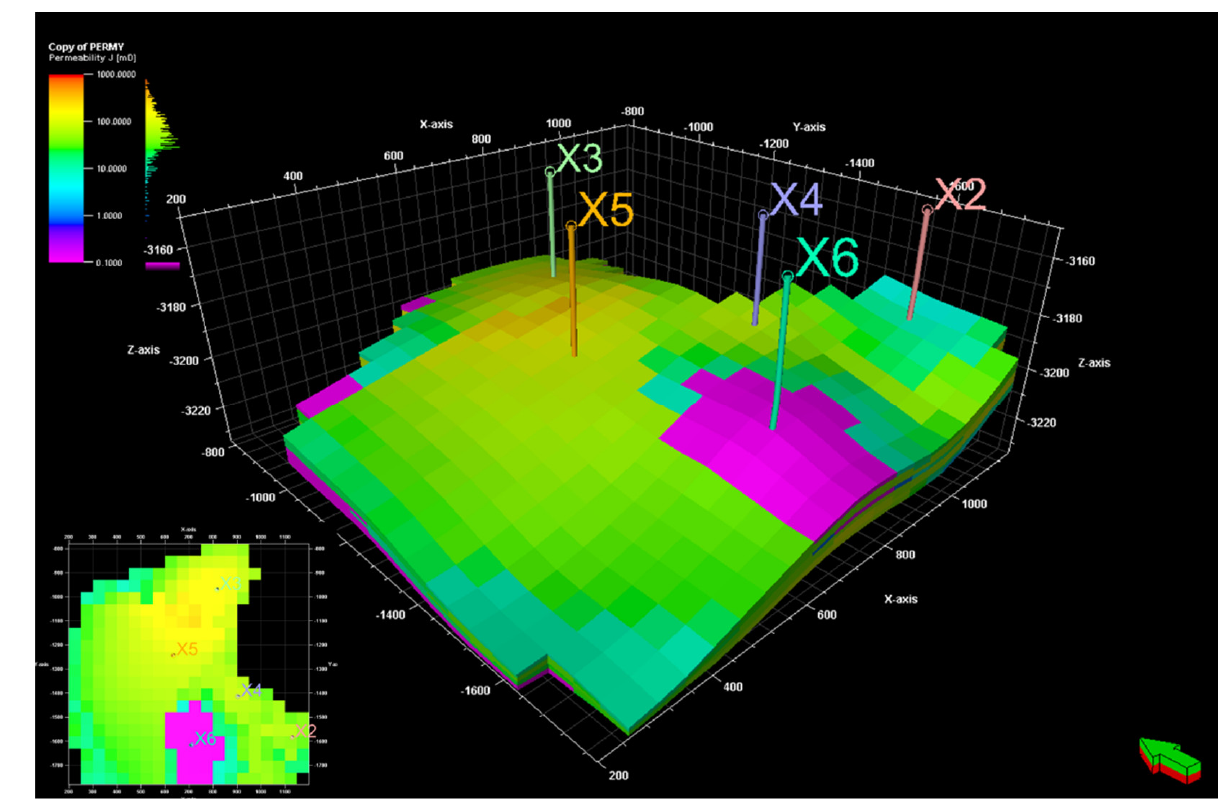
Figure 17. Permeability distribution and well pattern in the reservoir block.